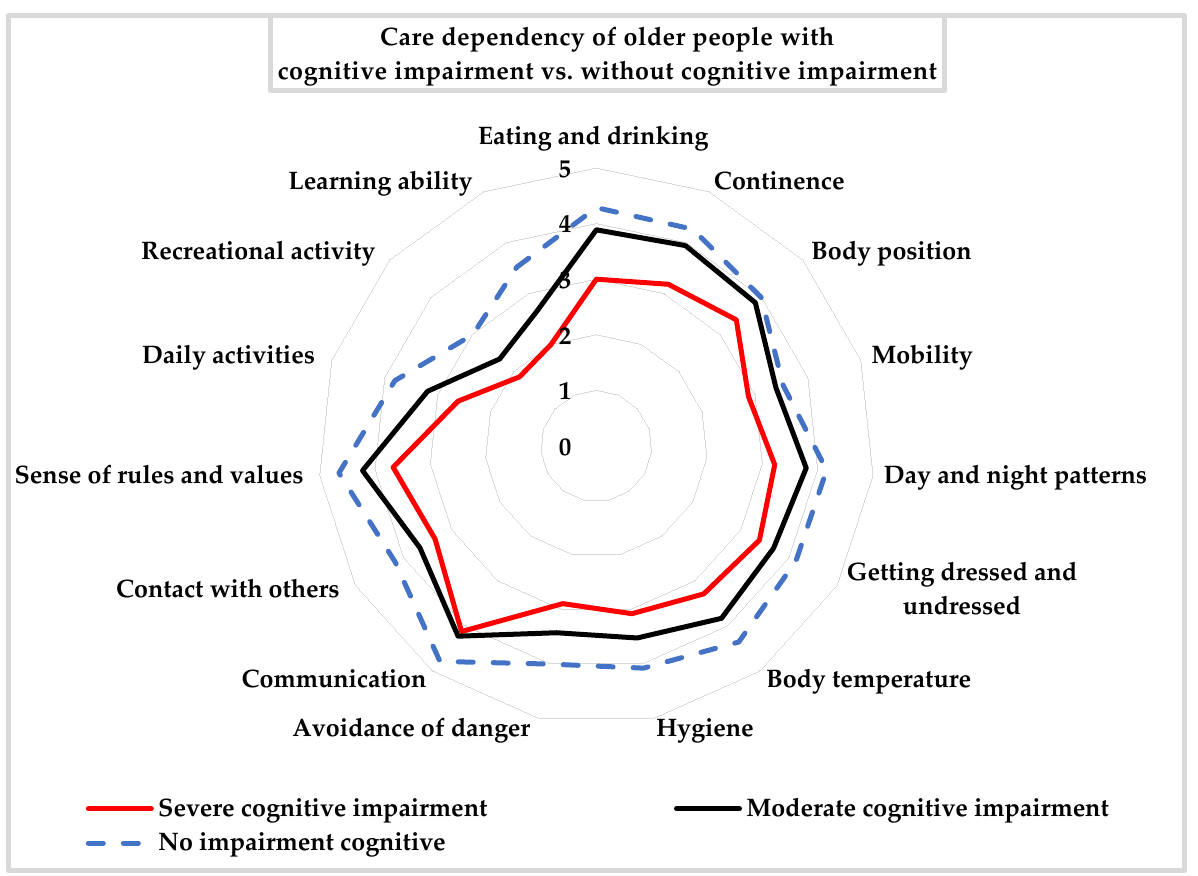
Figure 1. The level of severity of care dependency of older people with cognitive impairment vs. without cognitive impairment.